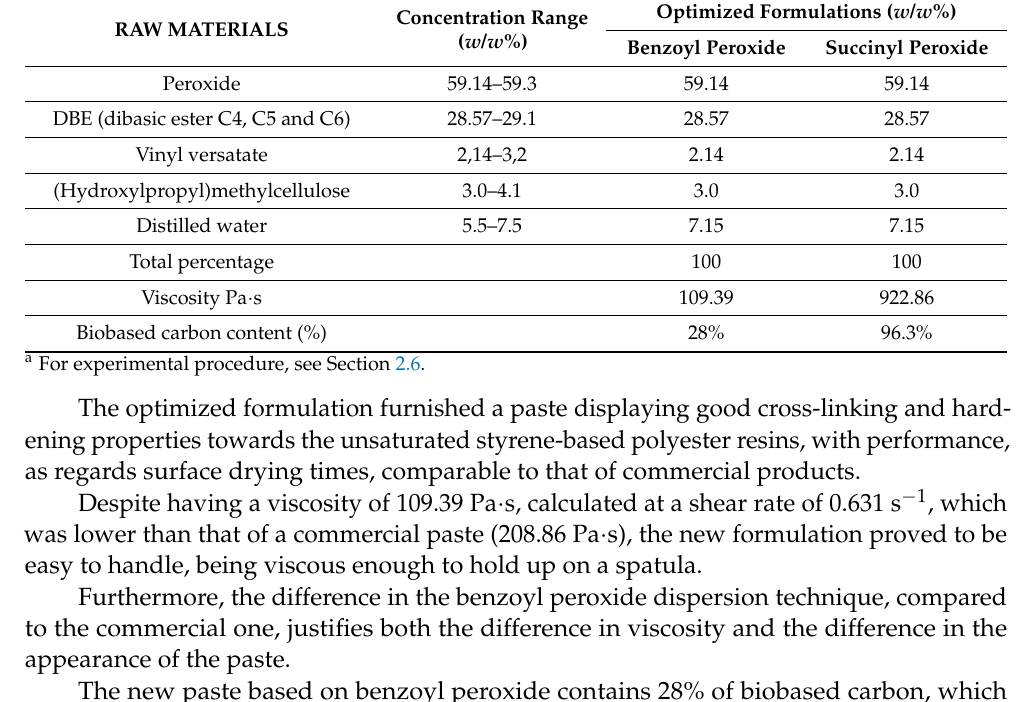
Table 3. Formulation of biobased paste as cross-linking agent for unsaturated polyester resins a . RAW